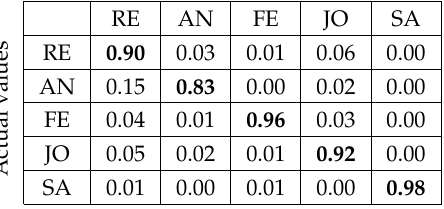
Table 11. Confusion matrix of joint fusion classifier in the FERA dataset. RE, Relief; AN, Anger; FE, Fear; JO, joy; SA, Sadness. RE AN